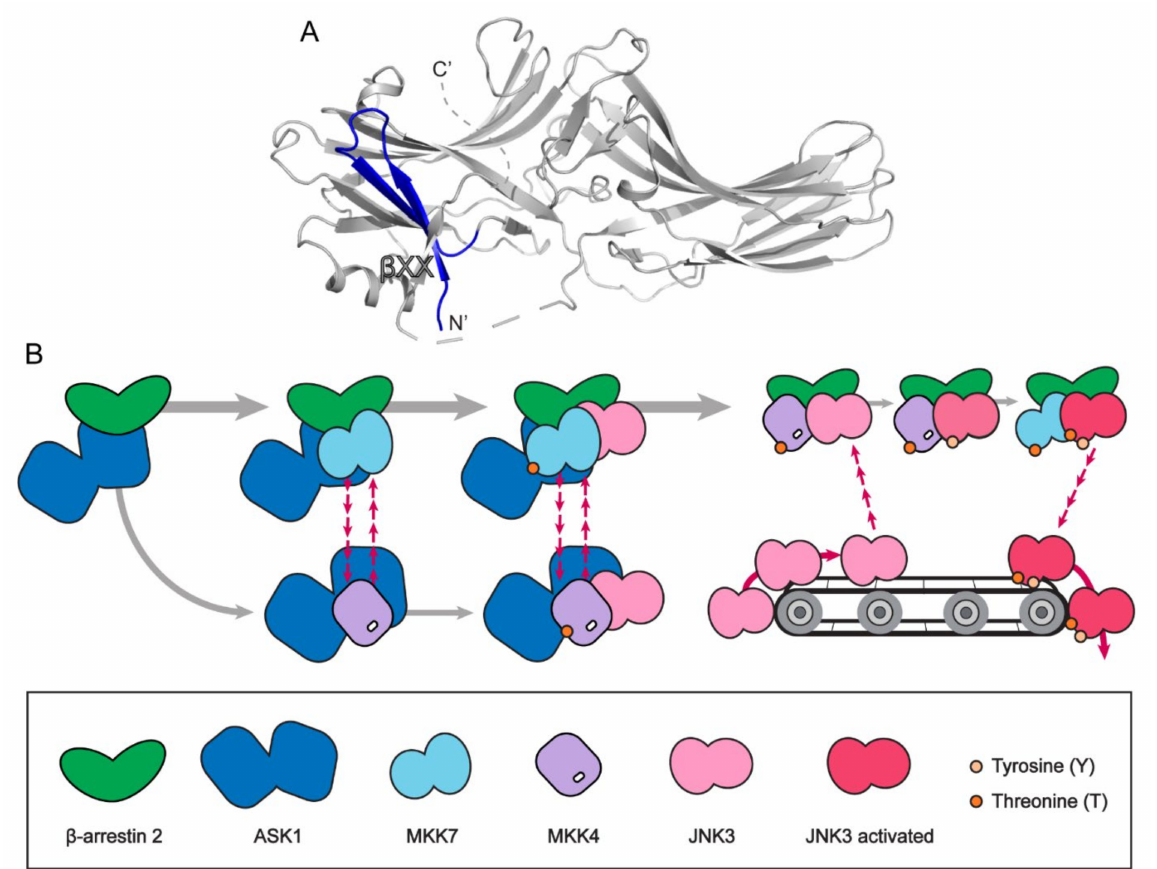
Figure 3. The JNK3 signaling scaffolding mechanism of β -arrestin 2. ( A ) The β -arrestin 2 structure with first 25 residues highlighted with blue (PDB: 3P2D). ( B ) The conveyor belt model of JNK3 signaling scaffolding mechanism of β -arrestin